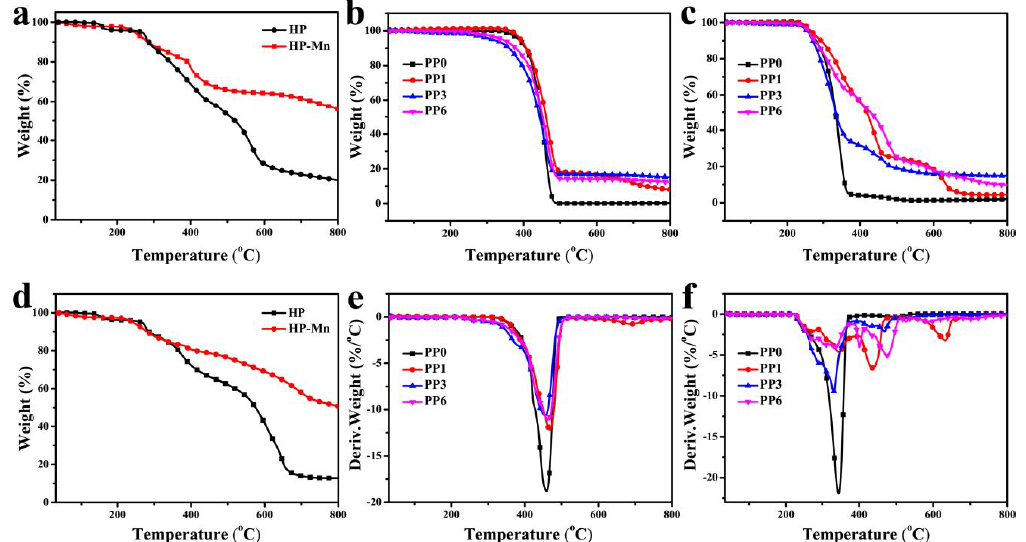
Figure 5. TGA ( a − d ) and DTG ( e , f ) of flame retardant, pure PP and flame retardant composites under nitrogen ( a , b , e ) and air atmosphere ( c , d , f ). Table 4. TG and DTG curves of HP, HP-Mn, Pure PP and its flame-retardant composites under nitrogen atmosphere.